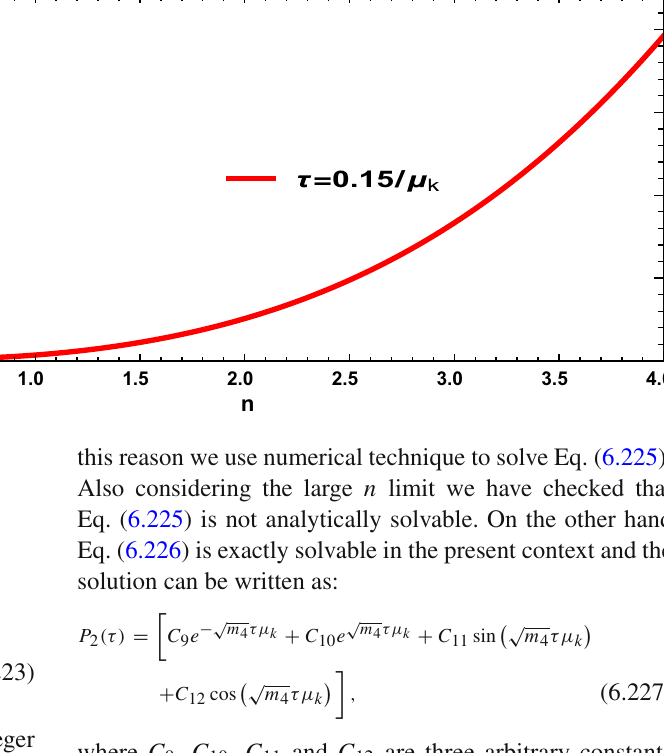
Fig. 42 Third order contribution to the probability density function with respect to the occupation number per mode n , for a fixed time from the analytical solution (Eq. 6.222) of third order correction equation (Eq.